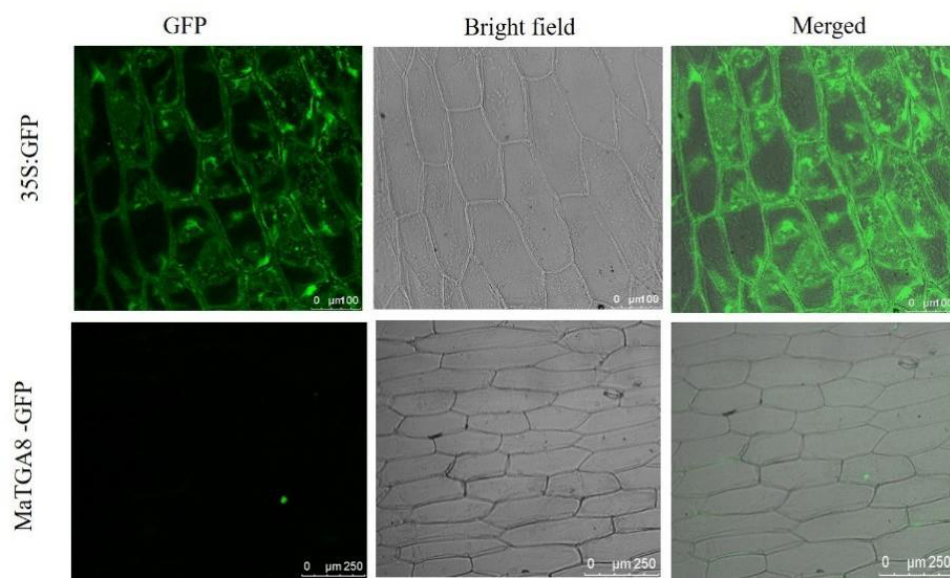
Figure 5. Subcellular localization of MaTGA8 gene.